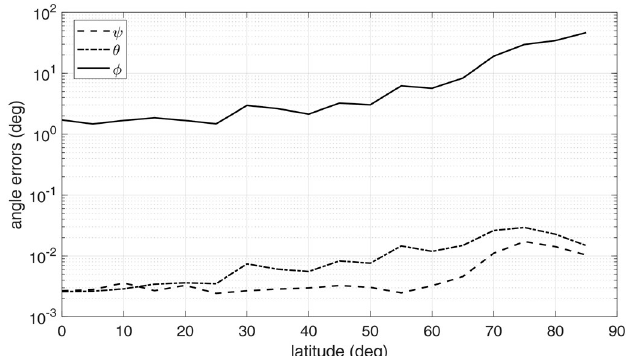
Figure 6. Attitude errors as a function of latitude for an Earth-like spheroid with atmosphere, h / R E = 0.1 [9].